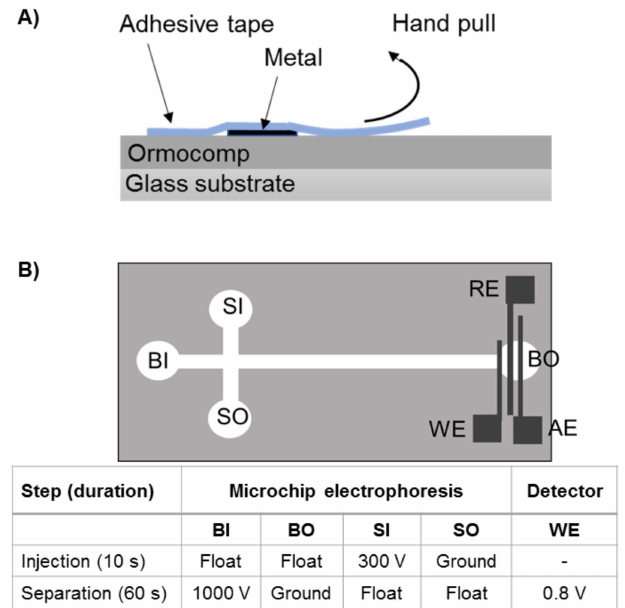
Figure 2. Schematic views of ( A ) the Scotch tape based adhesion test adopted from a previous work [25] and ( B ) the Ormocomp electrophoresis separation chip featuring Pt electrodes for on-chip amperometric detection, accompanied by a tabular presentation of the injection, separation, and detector voltages used in the proof-of-concept experiments. BI = bu ff er inlet, BO = bu ff er outlet, SI = sample inlet, SO = sample outlet, WE = working electrode, RE = reference electrode, AE = auxiliary electrode. In the electrophoresis experiments, the BO also served as the auxiliary electrode for the amperometric